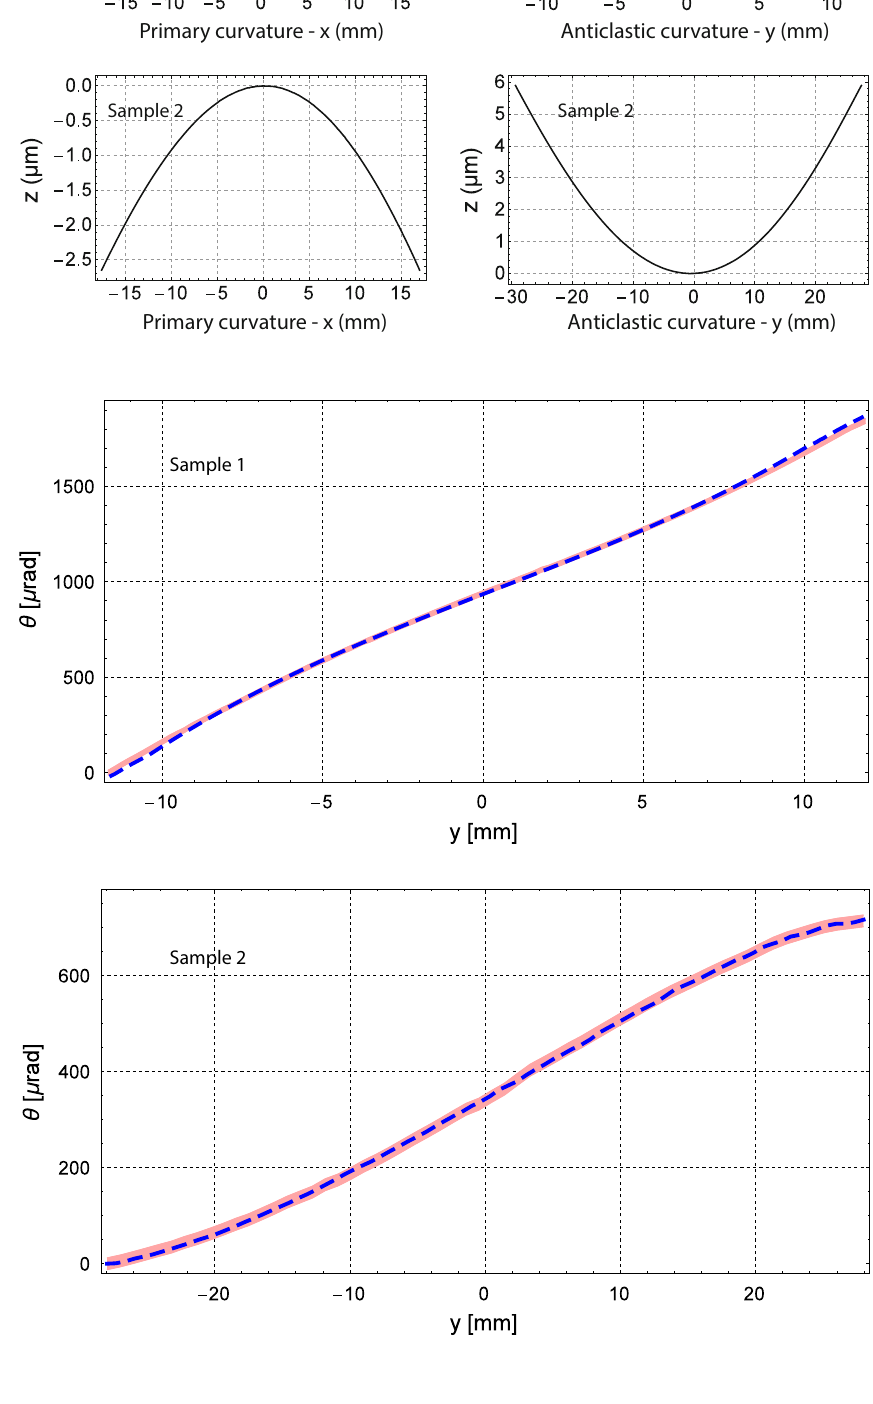
Fig. 4 X-ray measurement of the anticlastic deformation for the plate crystals. The red stripes represent the peak values θ with the instrument uncertainty. The dashed lines represent the numerical derivative of the corresponding interferometric